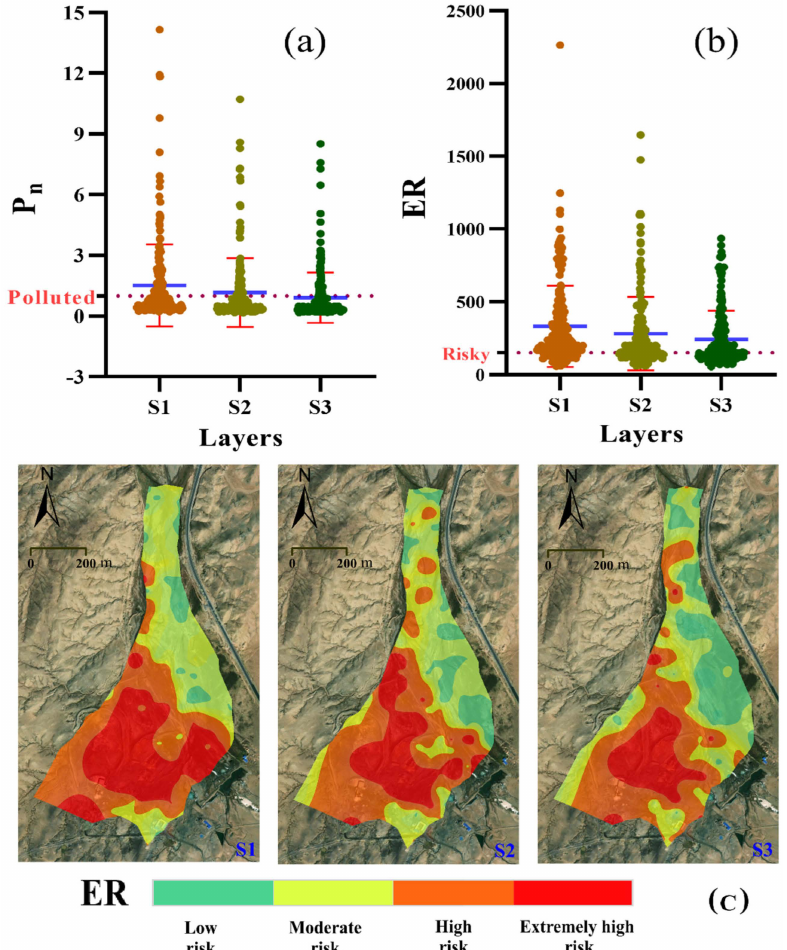
Figure 4. Evaluation results of P n and ER in different soil layers. ( a ): Evaluation results of the modified Nemerow index. ( b ): Evaluation results of the ecological risk index. ( c ): Distribution map of heavy metal ecological risk index in the evaluation area. S1: 0–10 cm soil layer; S2: 10–30 cm soil layer; S3: 30–50 cm soil